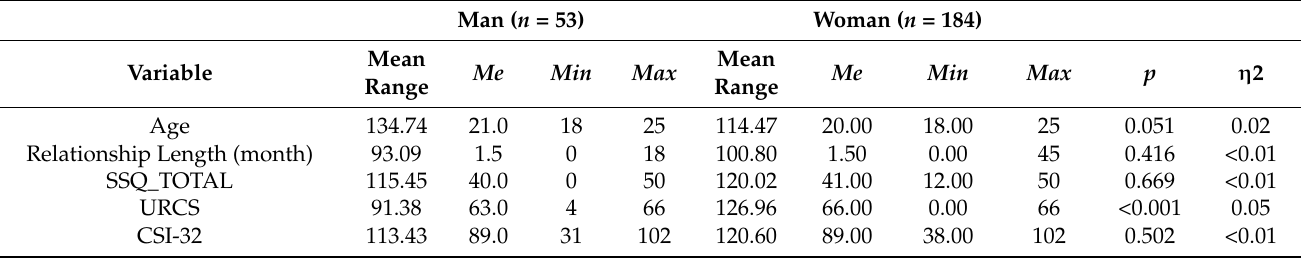
Table 2. Intergender differences in individual variables.